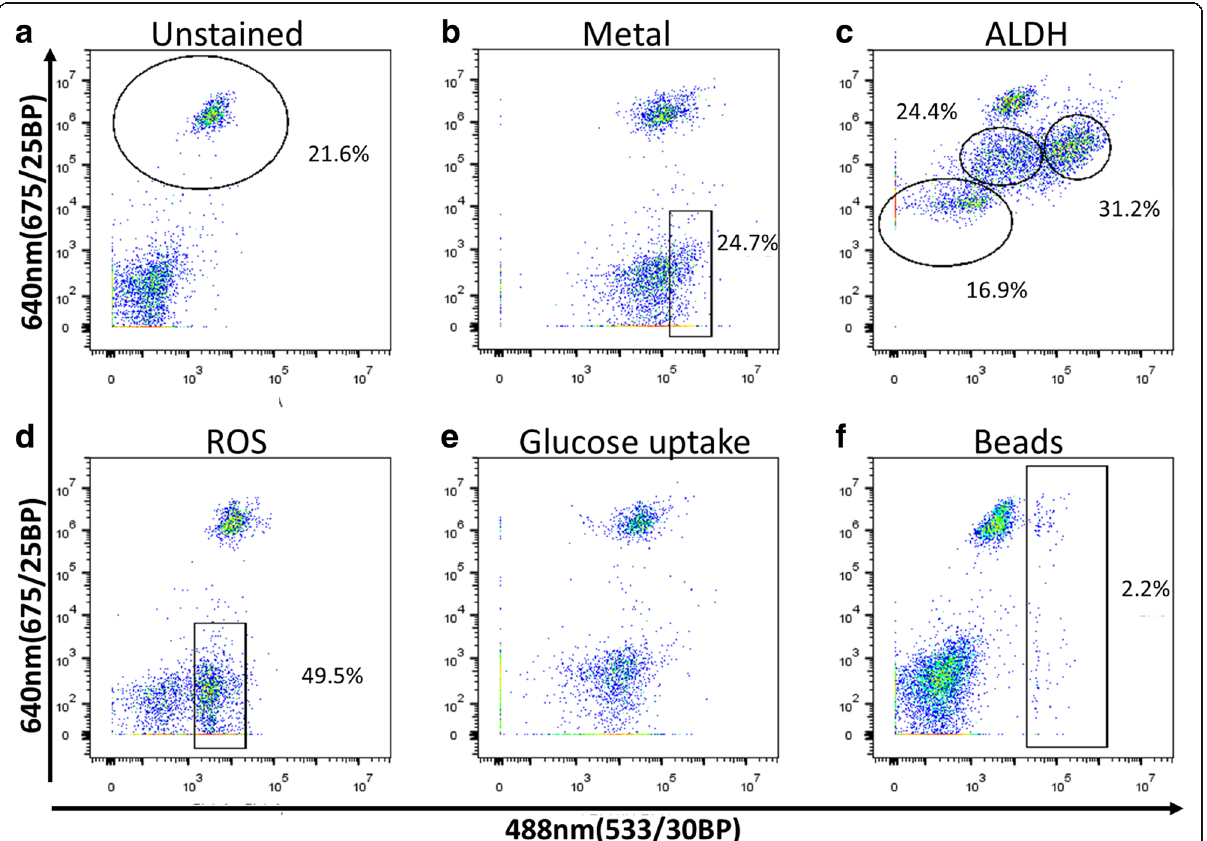
Fig. 5 A. pallida cells labeled with fluorescent markers. The A. pallida cell suspension was incubated with the same fluorescent markers that were used to label coral cells and analyzed on FACS AccuriC6. All the samples were analyzed on two dimensional plots of the 488 nm channel (533/ 30BP) which detects the fluorescent markers and on the Far-red 640 nm channel (675/25BP) which differentiates the Symbiodinium positive cells. Marked in the gates are the differentiated populations. The analysis was done after differentiation of cells and debris on FSC and SSC, and live/ dead cells using PI. a ) Background control of unstained cells in the gate are the Symbiodinium cells positive in the 640 nm channel